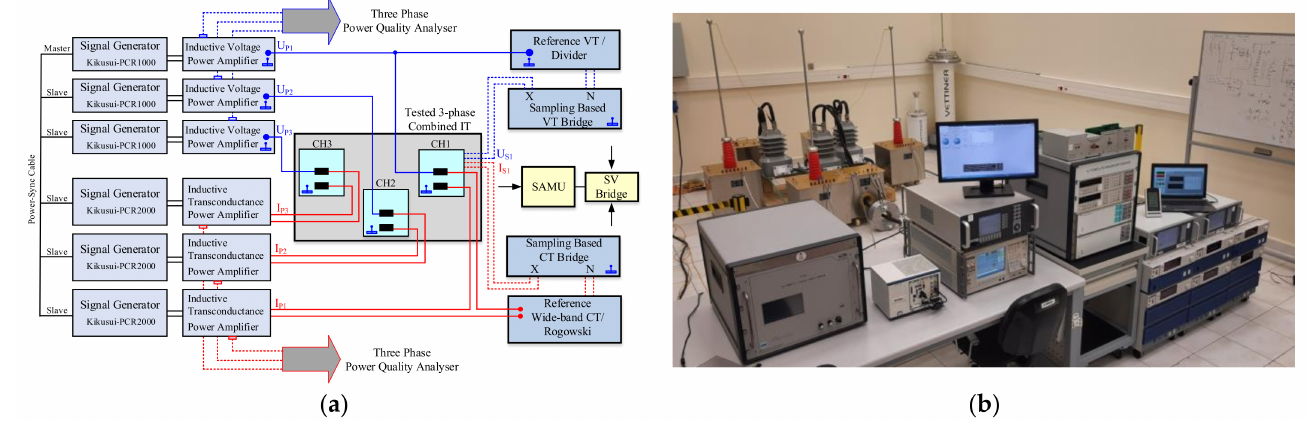
Figure 4. Block diagram ( a ) and picture ( b ) of the generation and measurement setup for MV combined ITs.